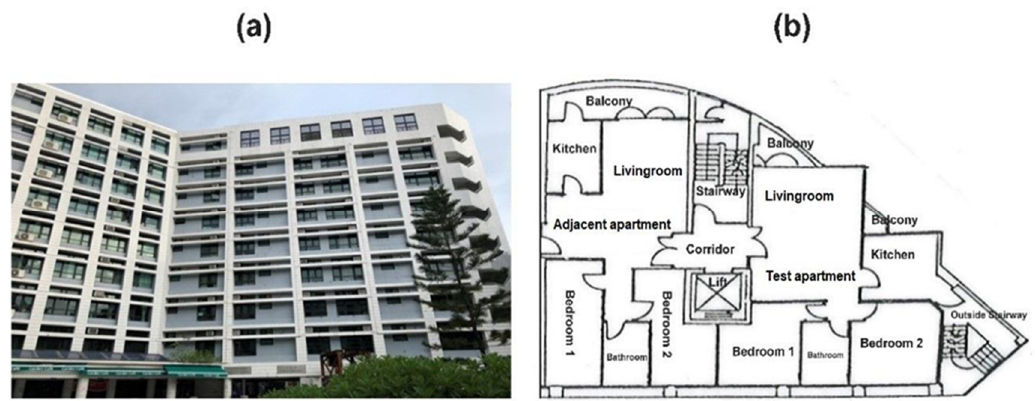
Figure 1. ( a ) The multistory apartment building; ( b ) floor layout; identical on each floor.